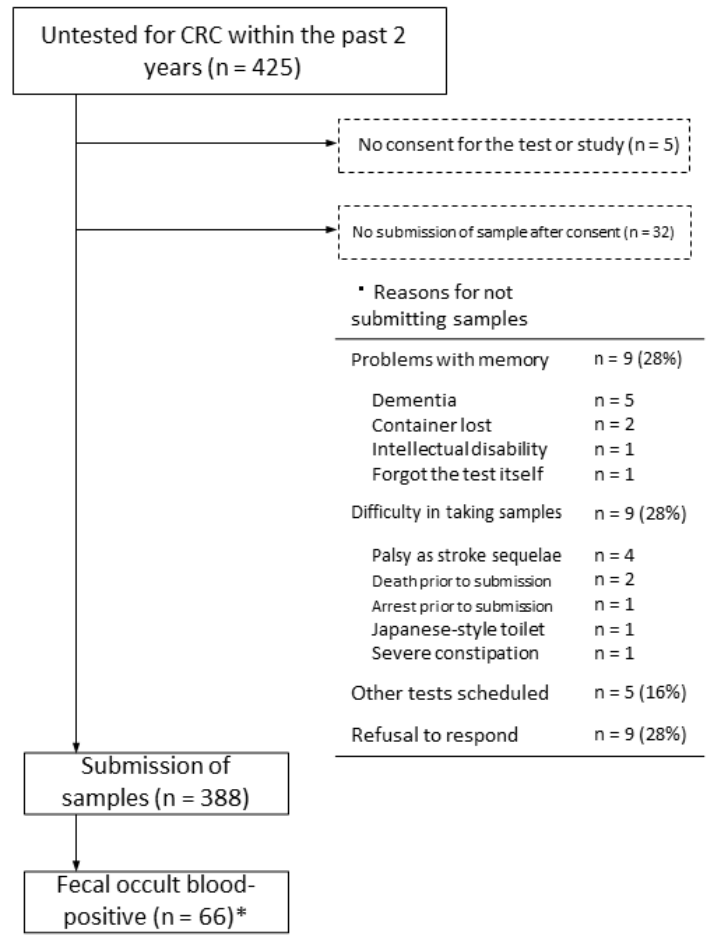
Figure 1. Flowchart of patients who were untested for CRC up to secondary testing. * Cohort study participants.